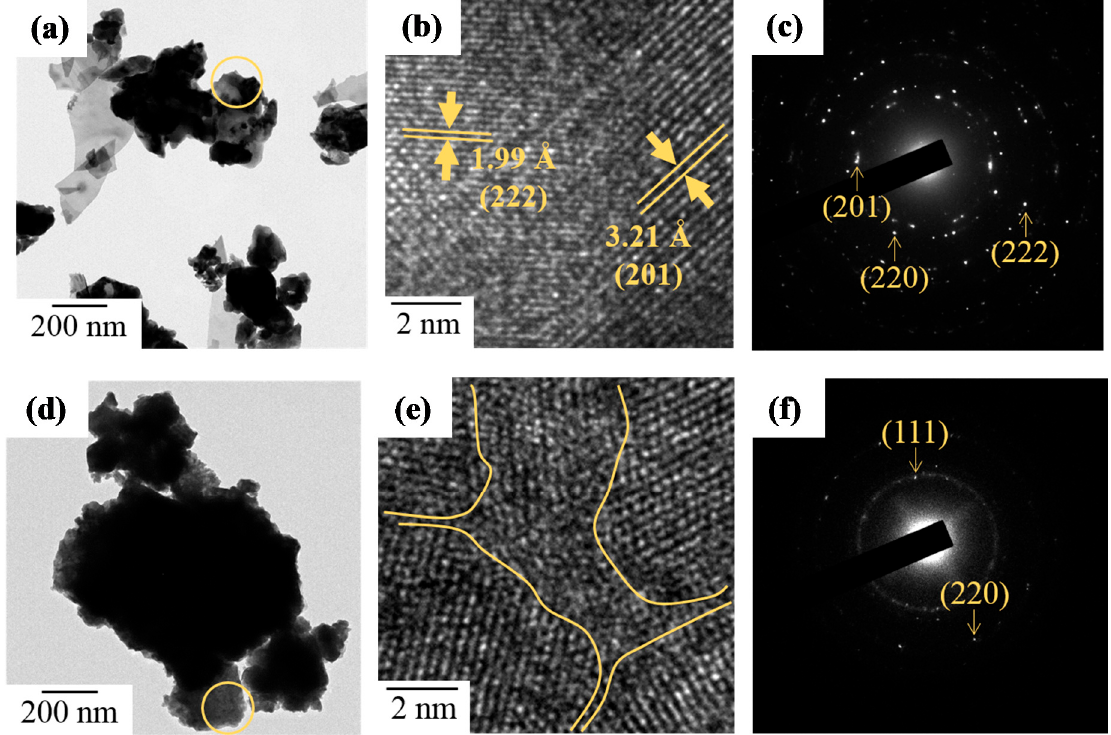
Figure 9. TEM images and SAED patterns of ( a – c ) Bi 1.8 Zr 0.2 O 3.1 and ( d – f ) Bi 1.0 Zr 1.0 O 3.5 powders after heat treatment at 500 °C.